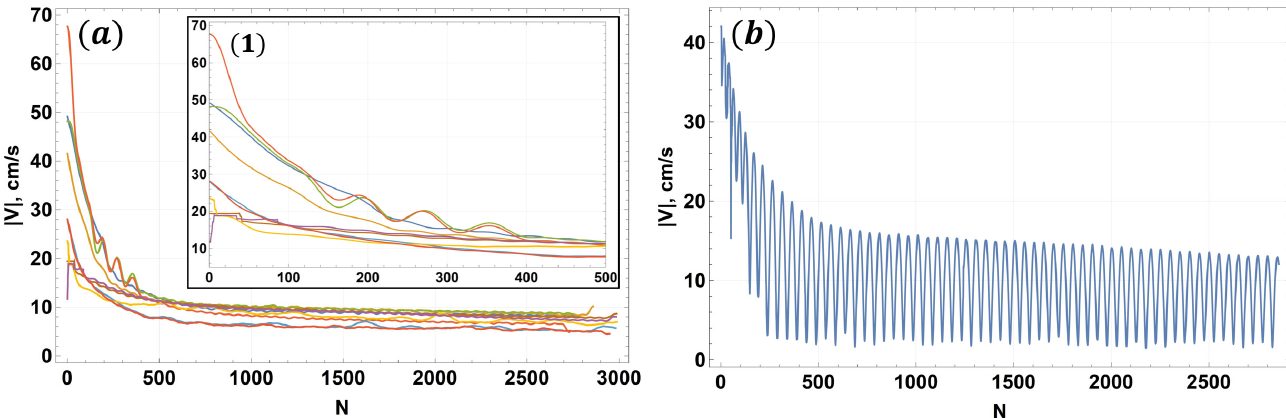
Figure 27. Frame pair velocimetry (magnitude) for the moving body (Figure 22): ( a ) velocity over sequential frames for all recorded image sequences with oscillations filtered out for visual clarity; ( b ) velocity for one of the image sequences with oscillations shown. ( a1 ) shows the first 500 frames in ( a ). Gaussian TV filtering was used for ( a , b ) with the regularization parameters set to 5 (150 iterations) and 0.5,